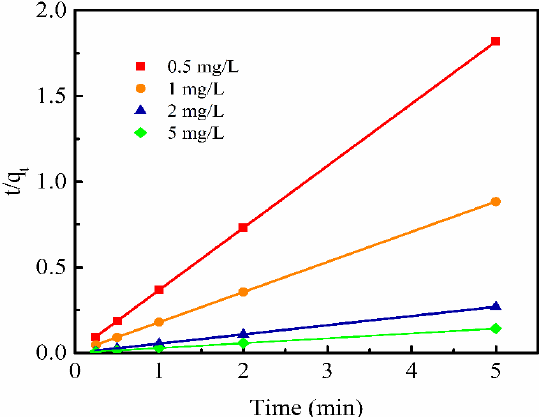
Figure 7. Fitting diagram of quasi-second-order kinetic model for carbon black adsorption of TCS. Table 2. Model parameters of adsorption kinetics of CB on TCS in